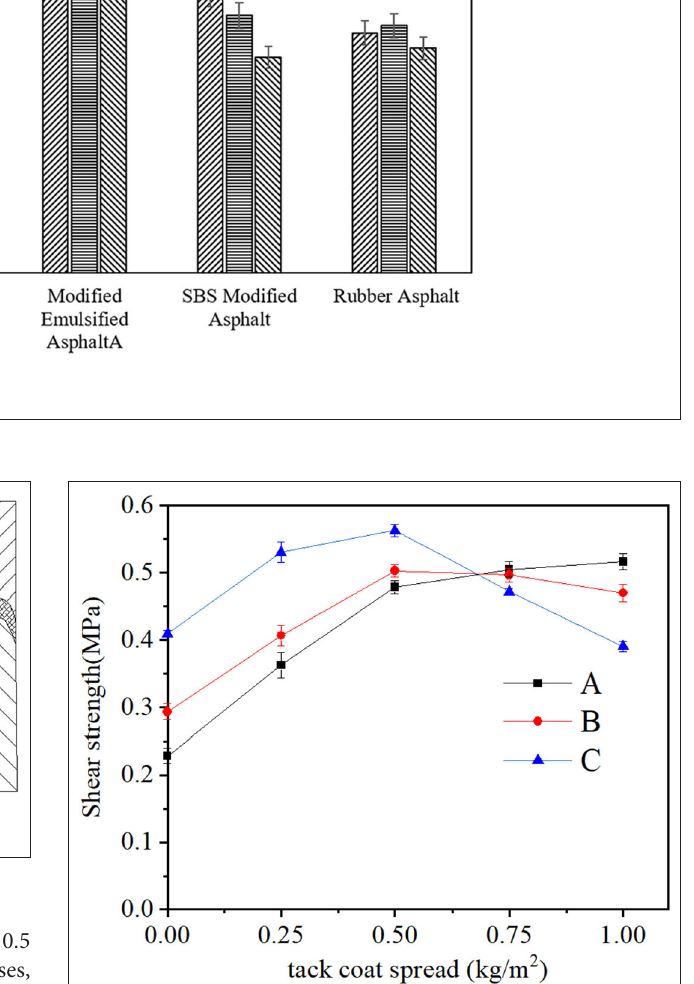
and the maximum shear strengths are obtained at 0.75 and 0.5